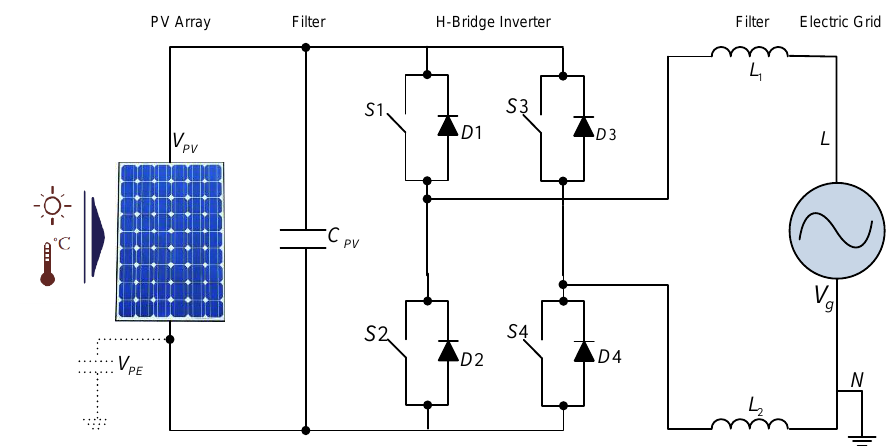
Figure 3. Basic structure of FB inverter [43].